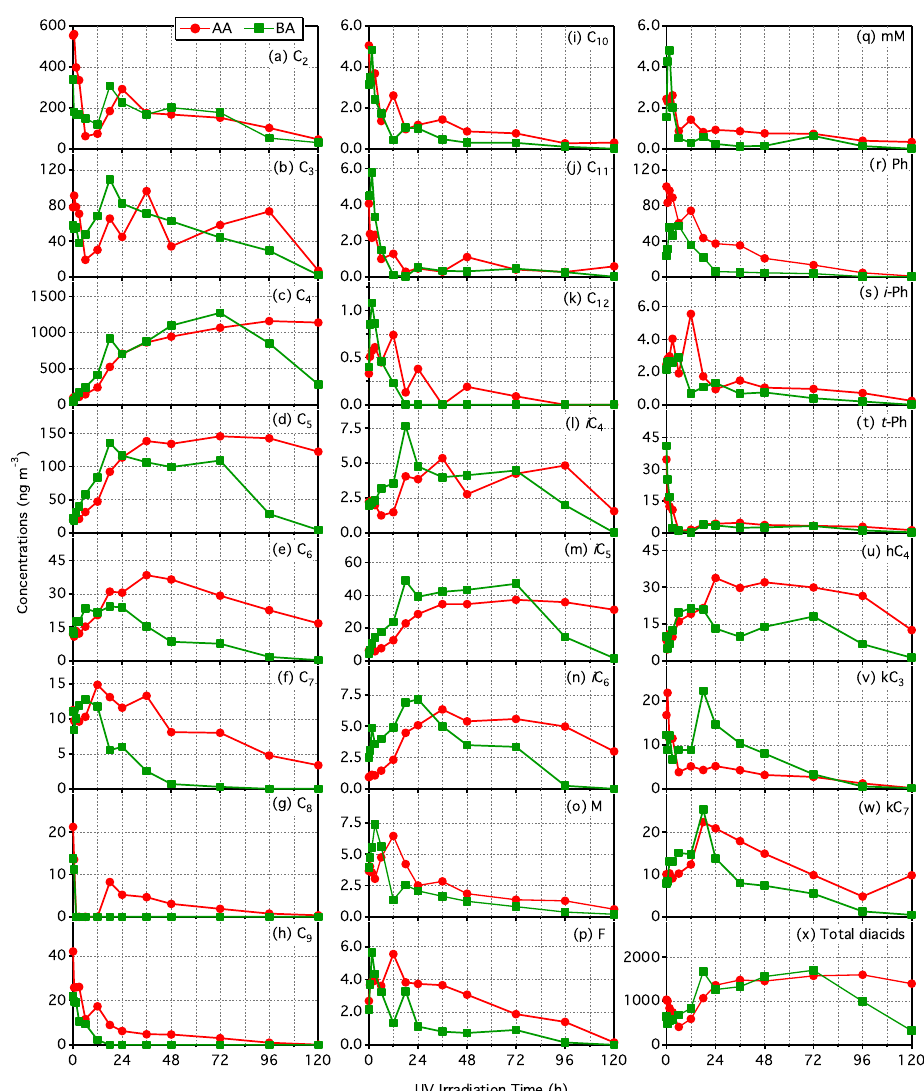
Figure 3. Changes in concentrations of individual dicarboxylic acids and total diacids as a function of UV irradiation time in anthropogenic (AA) and biogenic aerosols